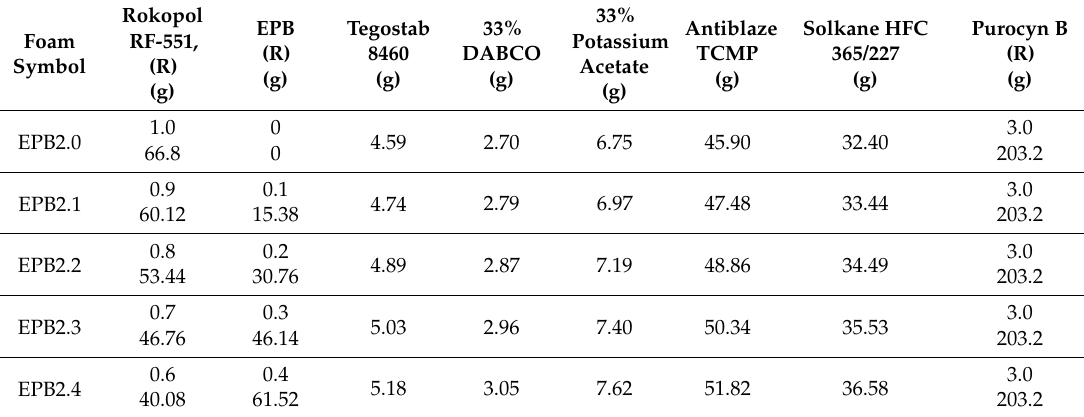
Table 2. Formulation of rigid polyurethane–polyisocyanurate (RPU/PIR) foams. DABCO: 1,4-